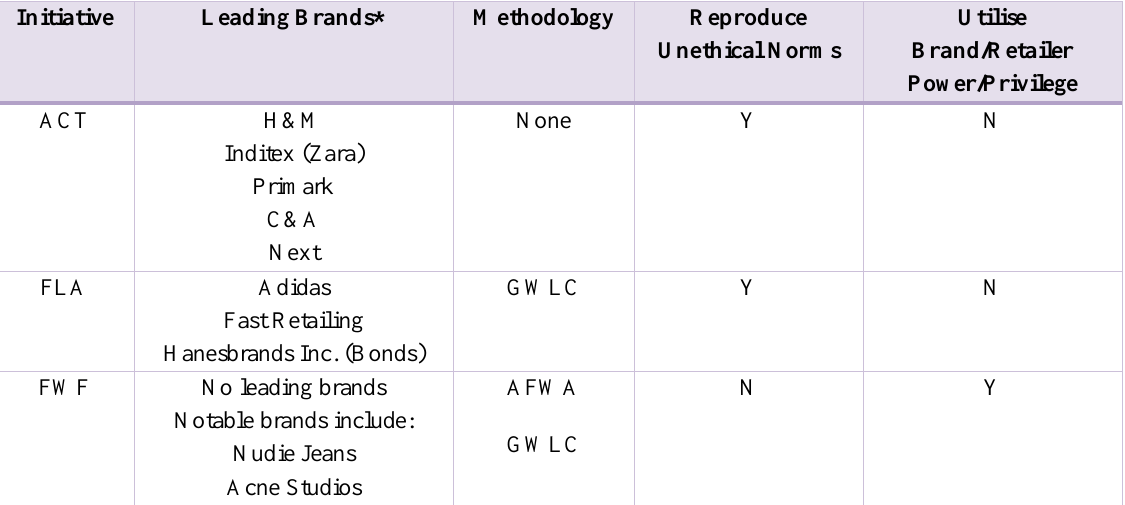
Table 2. Summary of living wage initiative findings Initiative Leading Brands* Methodology Reproduce